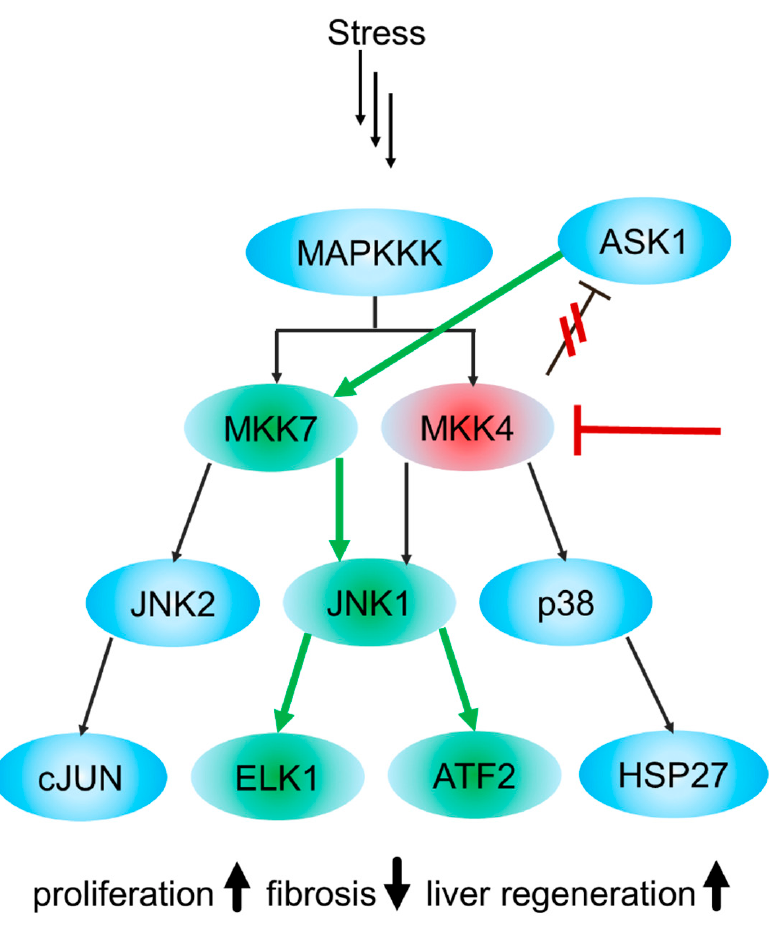
Figure 9. Overview of the inhibited MKK4 signaling pathway. Red arrow shows the downregulation or inhibition of MKK4. Red lines demonstrate the lack of negative feedback effect of MKK4 on ASK1. Green arrows show increased activation of the MAP kinase cascade due to an absence of MKK4 activity. Adapted from Wuestefeld et al. [119].